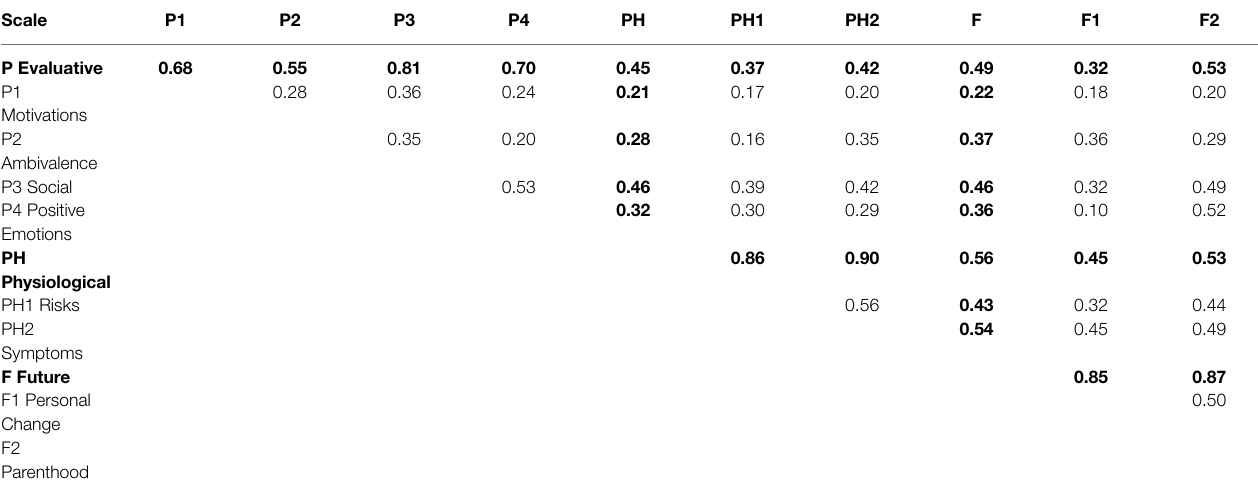
TABLE 3 | Correlations among the pregnancy perception questionnaire scale. N = 290.